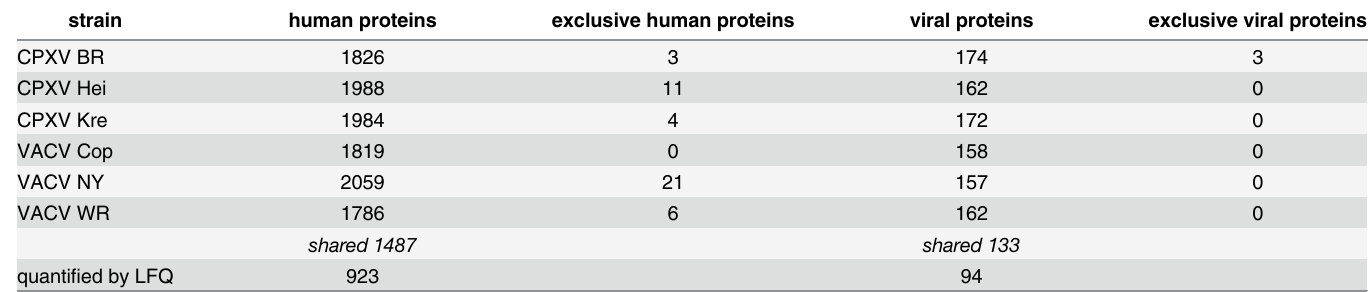
Table 1. Number of identified